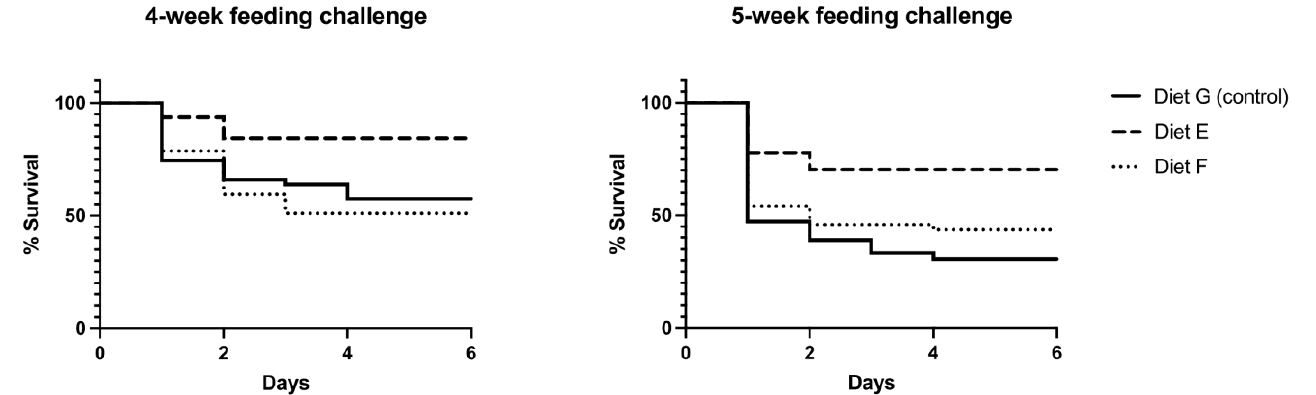
Figure 3. Cumulative mortalities and percentage of survival in shrimps fed functional diets E and F or control diet G (for 4 or 5 weeks) and challenged with Vibrio parahaemolyticus ( Vp AHPND strain). Challenge data (excluding the group maintained in E3 tank) were subjected to logistic regression analysis. The “casualty” and “survivor” data of the shrimp fed CTRL diet G in challenge 1 (G1 tank) were used as reference for comparison, with the mortality of this group represented in the intercept of the model. The results of the analysis showed signif- icant differences in the probability of death in the group fed functional diet E challenged after 4- or 5-week feeding with respect to the intercept.